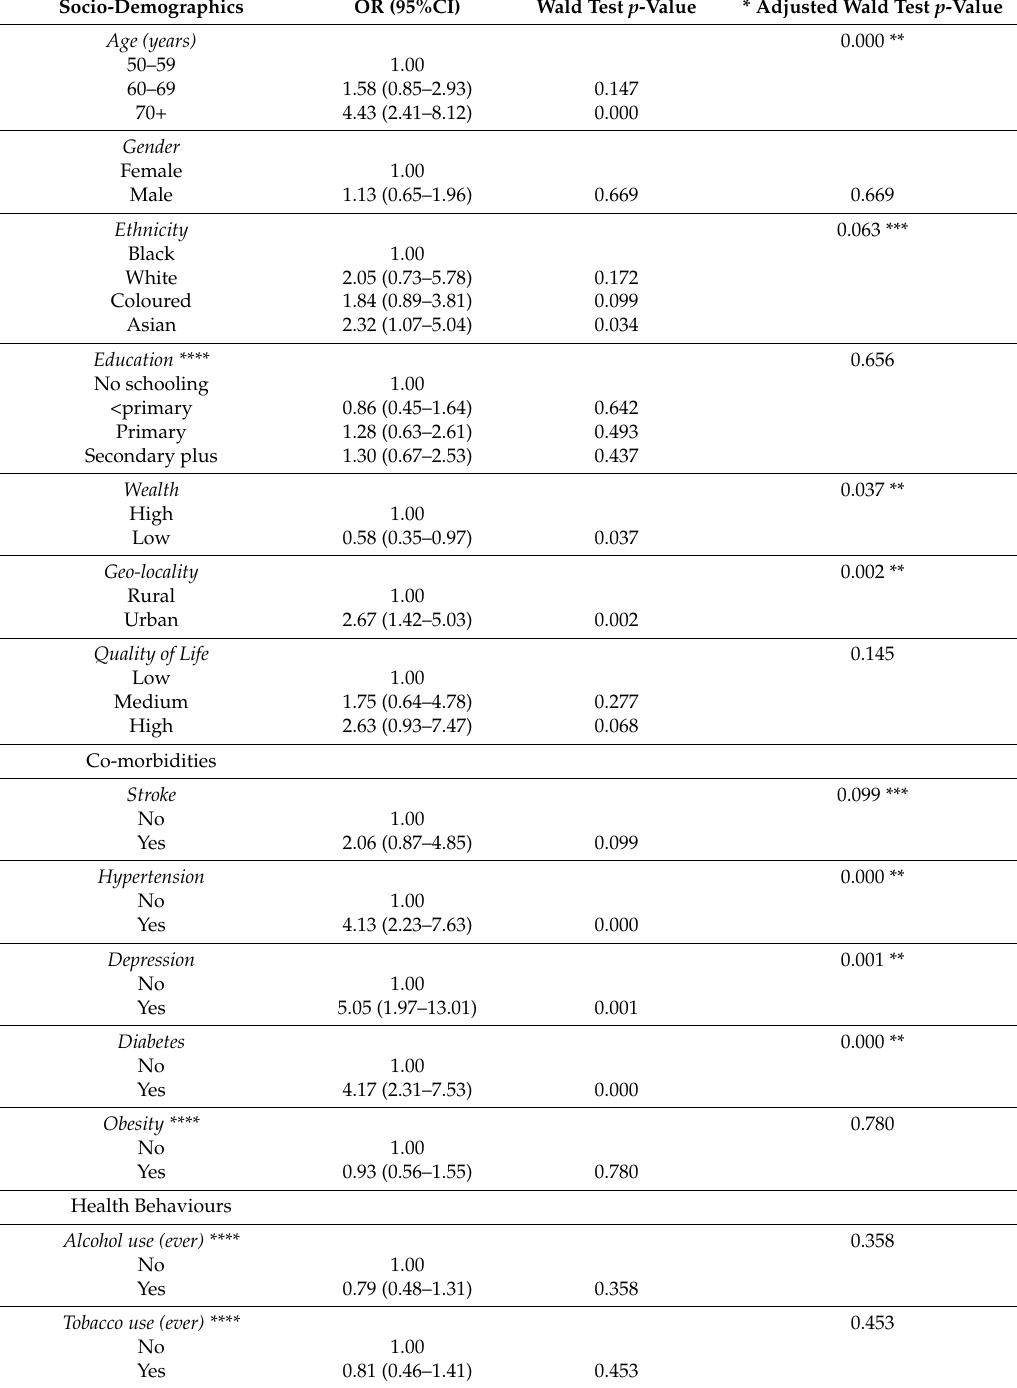
Table 2. Crude associations between self-reported cataract and exposures (Model